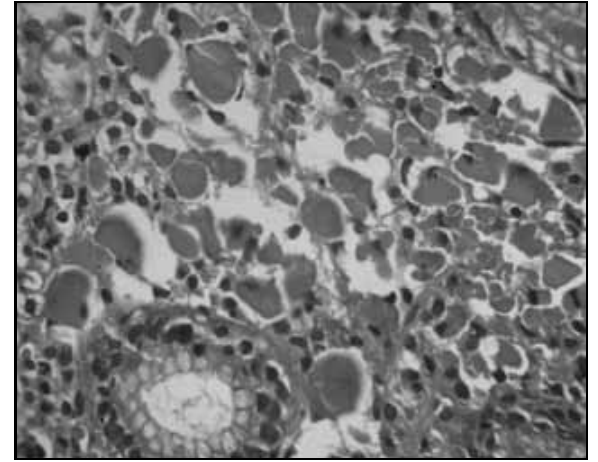
Figure 2 – Gastric biopsy showing several plasma cells with numerous intracytoplasmic eosinophilic round structures compatible with Russell body, hematoxylin- eosin, 400×